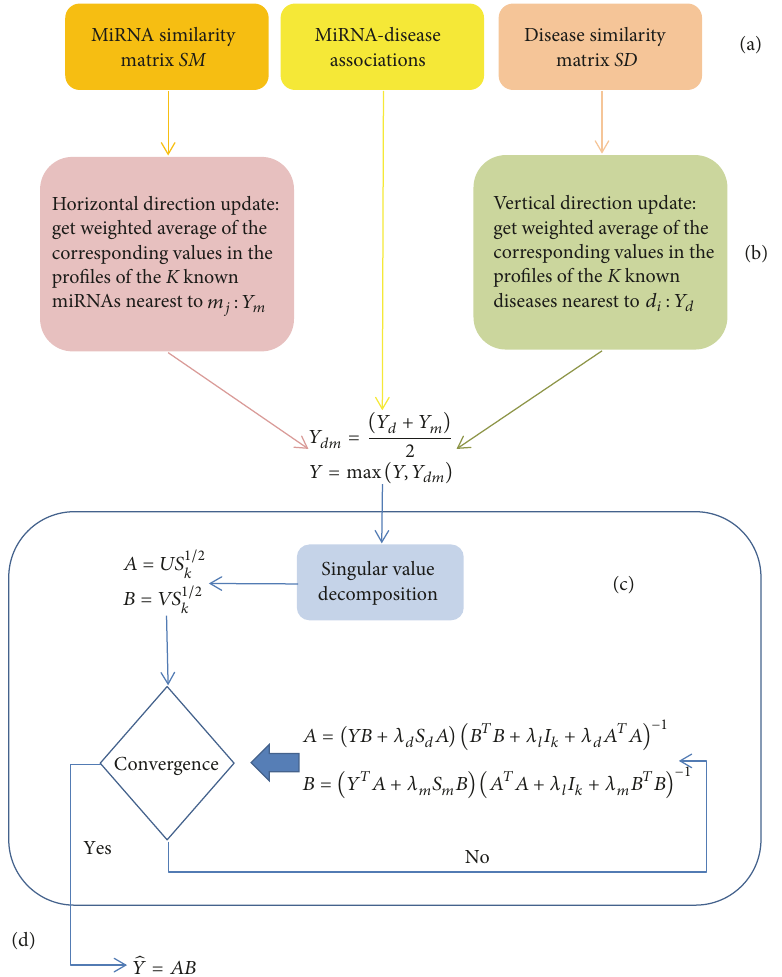
Figure 1: Flowchart of potential miRNA-disease associations prediction based on